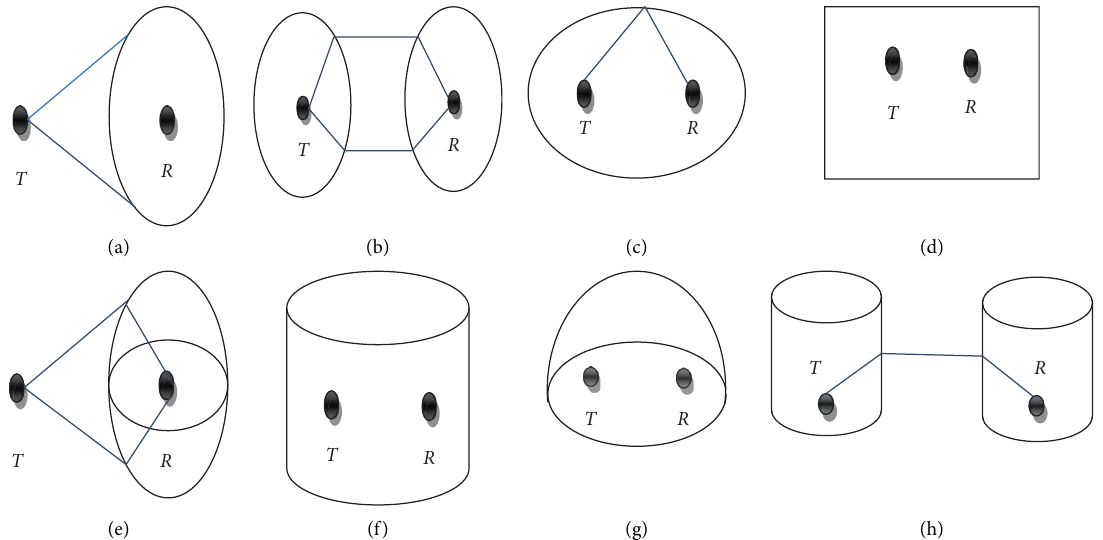
Figure 1: Classical regular-shape GBSMs, (a) one-ring, (b) two-ring, (c) ellipse, (d) rectangle, (e) one-sphere, (f) elliptical cylinder, (g) semiellipsoid, and (h) two-cylinder.